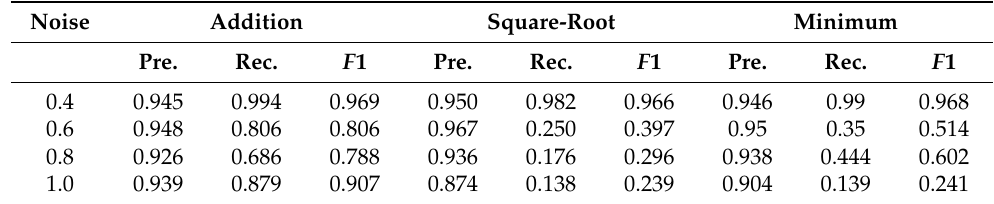
Table 2. Performance achieved with both DP enhancement and DP tracing using addition/arithmetic mean (Equation (6)), geometric mean (Equation (7)), and minimum (Equation (8)) blending functions. Noise Addition Square-Root Minimum Pre. Rec. F 1 Pre. Rec. F 1 Pre. Rec. F 1 0.4 0.945 0.994 0.969 0.950 0.982 0.966 0.946 0.99 0.968 0.6 0.948 0.806 0.806 0.967 0.250 0.397 0.95 0.35 0.514 0.8 0.926 0.686 0.788 0.936 0.176 0.296 0.938 0.444 0.602 1.0 0.939 0.879 0.907 0.874 0.138 0.239 0.904 0.139